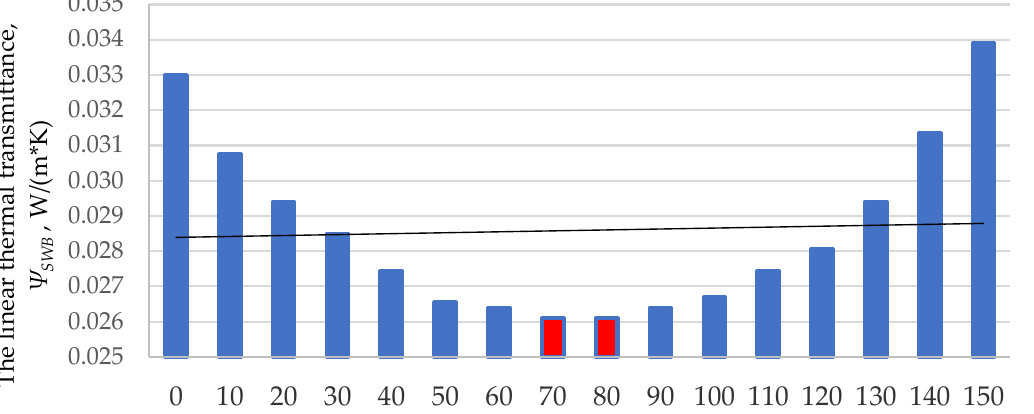
Figure 9. Dependence of the value of thermal transmittance on the installation length in SWB from the place of window to the load-bearing layer.